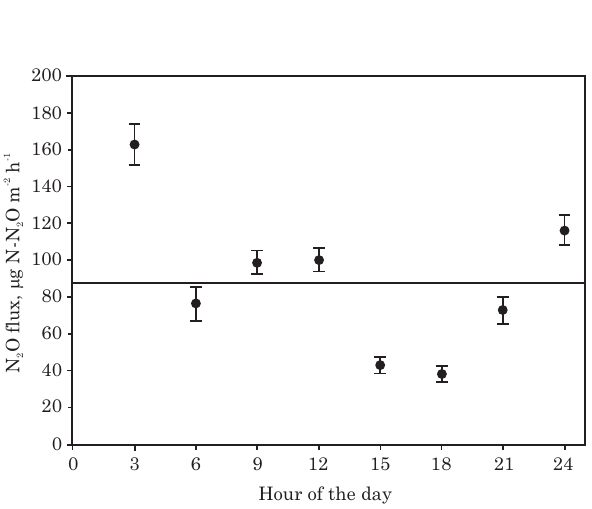
Figure 1. Dynamics of N 2 O emission rates during the day. Bars indicate standard error of the means. The horizontal line corresponds to the